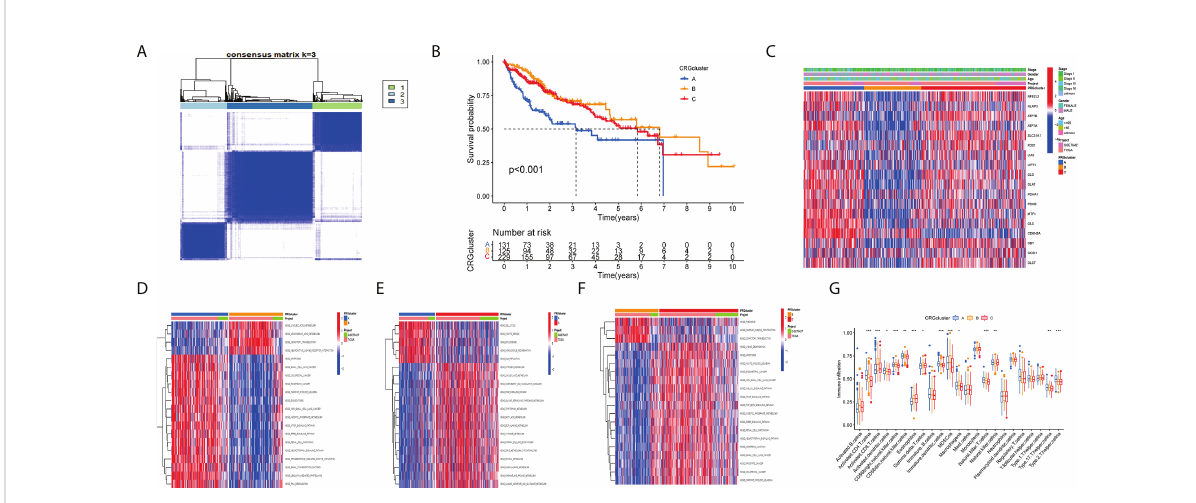
FIGURE 4 Clustering analyses of the signature. (A, B) Concordance matrix and K-M survival curve of the three clusters. (C) Complex heat maps show clinical correlations among the three clusters. (D – F) The GSVA heat map showed the differences in pathways in the three clusters. (G) The differential analyses between immune cells and the scale of fraction for cluster A and cluster B and cluster C. *p<0.05, **p<0.01,